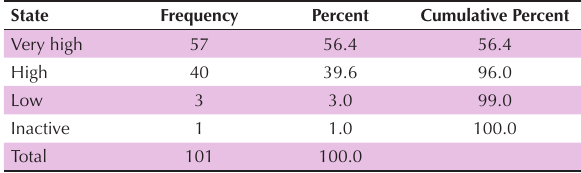
Table 8. Frequency of patients at each stage of treatment (note that only